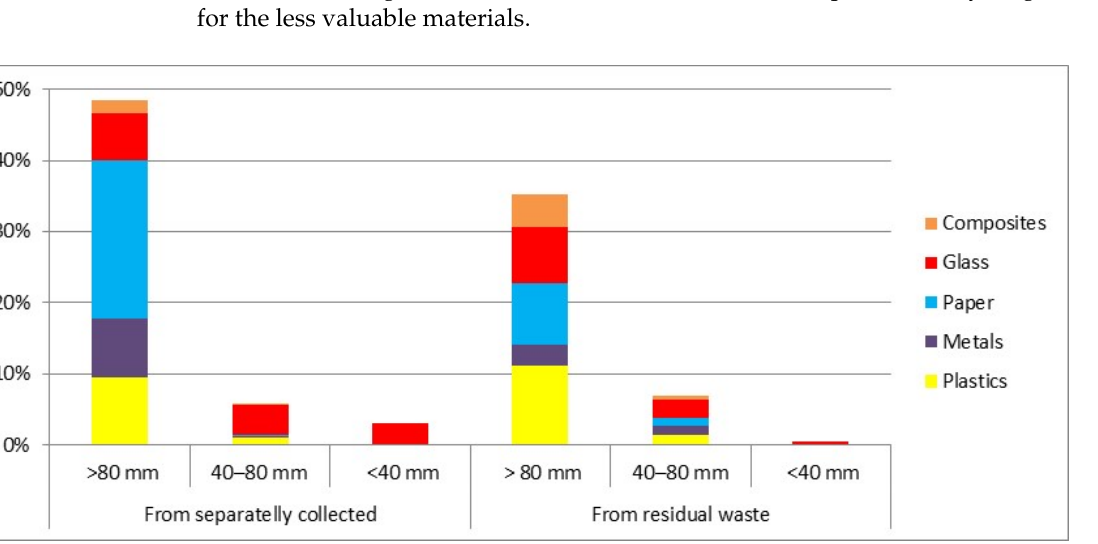
Figure 11. Contribution of materials derived from different waste fractions to obtain 50% recycling of all recyclables.